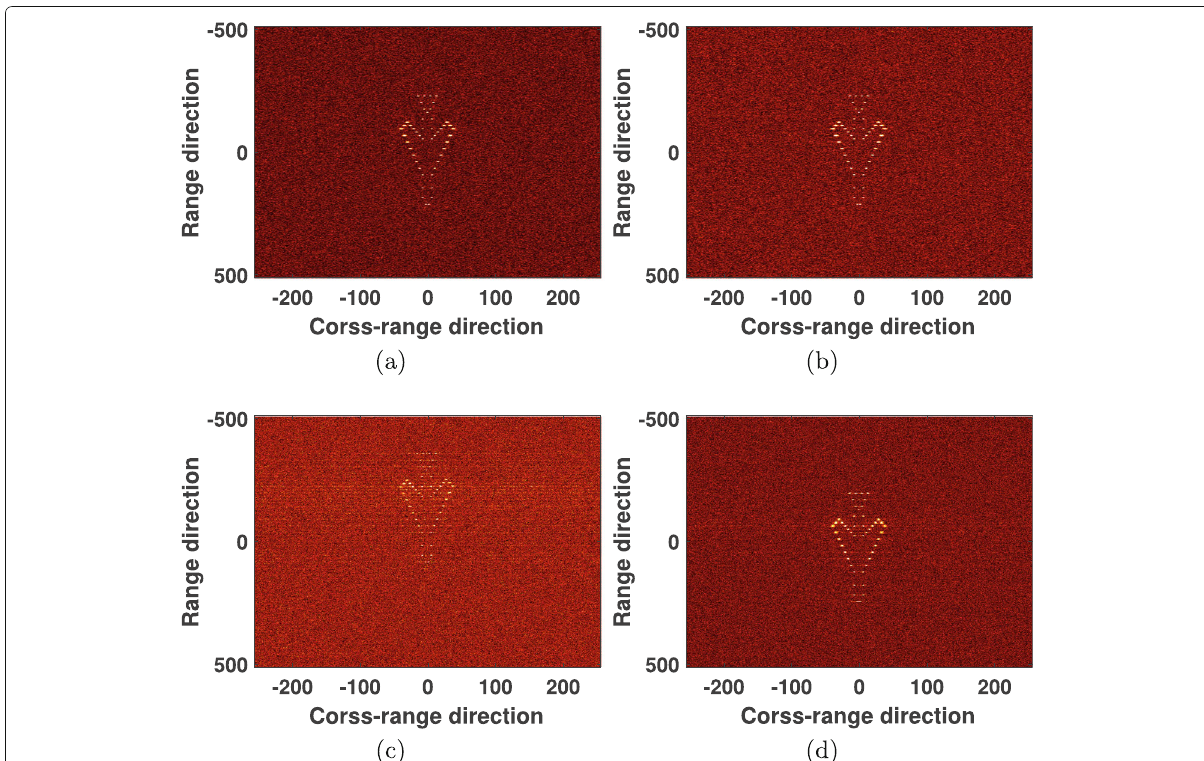
Fig. 6 Imaging results of the different methods under a − 10 dB SNR. a The ideal ISAR image, b the imaging result of the proposed algorithm, c the imaging result of the ACM, and d the imaging result of the MEARP